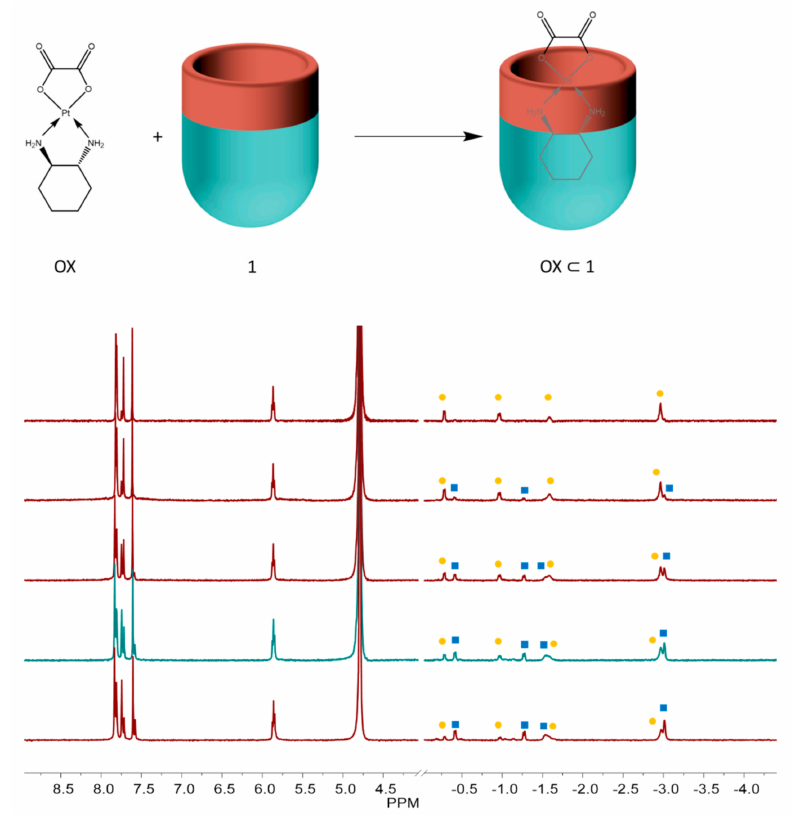
Figure 5. Top : Formation of host–guest complex by mixing an equimolar amount of oxaliplatin and cavitand 1 in water. Bottom : Partial 1 H NMR spectra of the host–guest complex formed between equimolar oxaliplatin and cavitand 1 in D 2 O, as a function of time: for from bottom to top 1 h, 12 h, 24 h, 4 days and 7 days. The guest exhibits two group of peaks labeled with dots and squares,